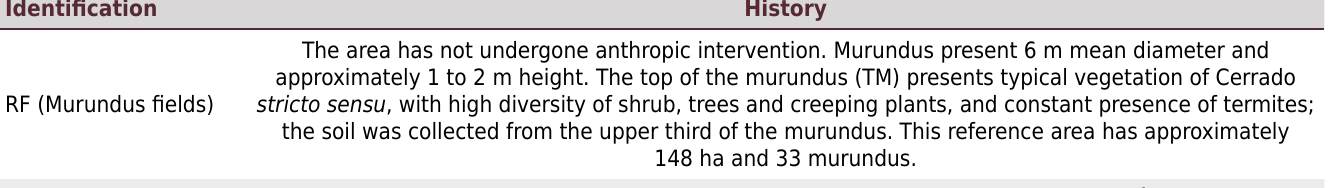
Table 2. Identification and history of management and use of the study areas